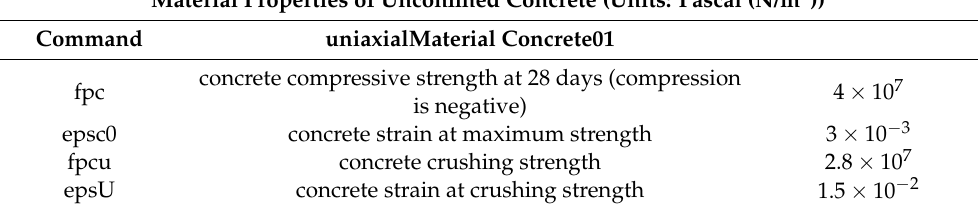
Table 3. Unconfined concrete material properties.